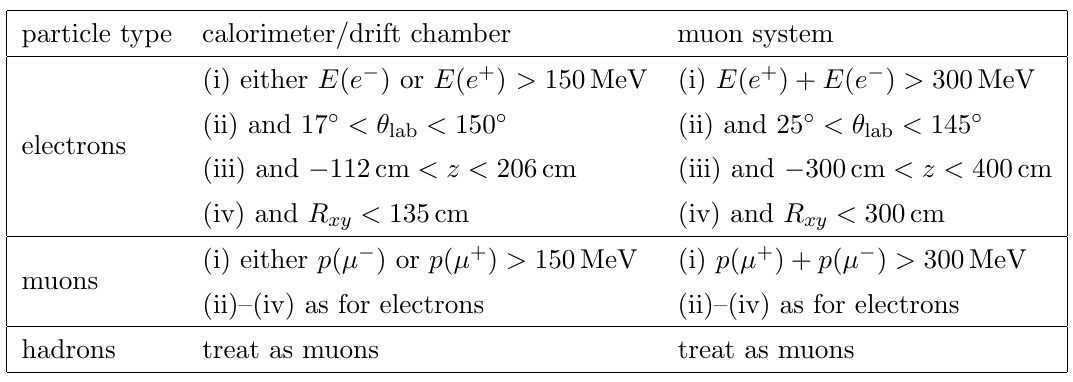
Table 1 . Vetoes on electrons, muons, and hadrons used for the Belle II mono-photon analysis rescaling. The variables (cid:18) lab , z , and R xy refer to the (cid:31) 2 decay vertex in the laboratory frame. (cid:18) lab is the polar angle between the decay vertex and positive z direction, and R xy is the distance between the z axis and the decay vertex in the plane perpendicular to the z